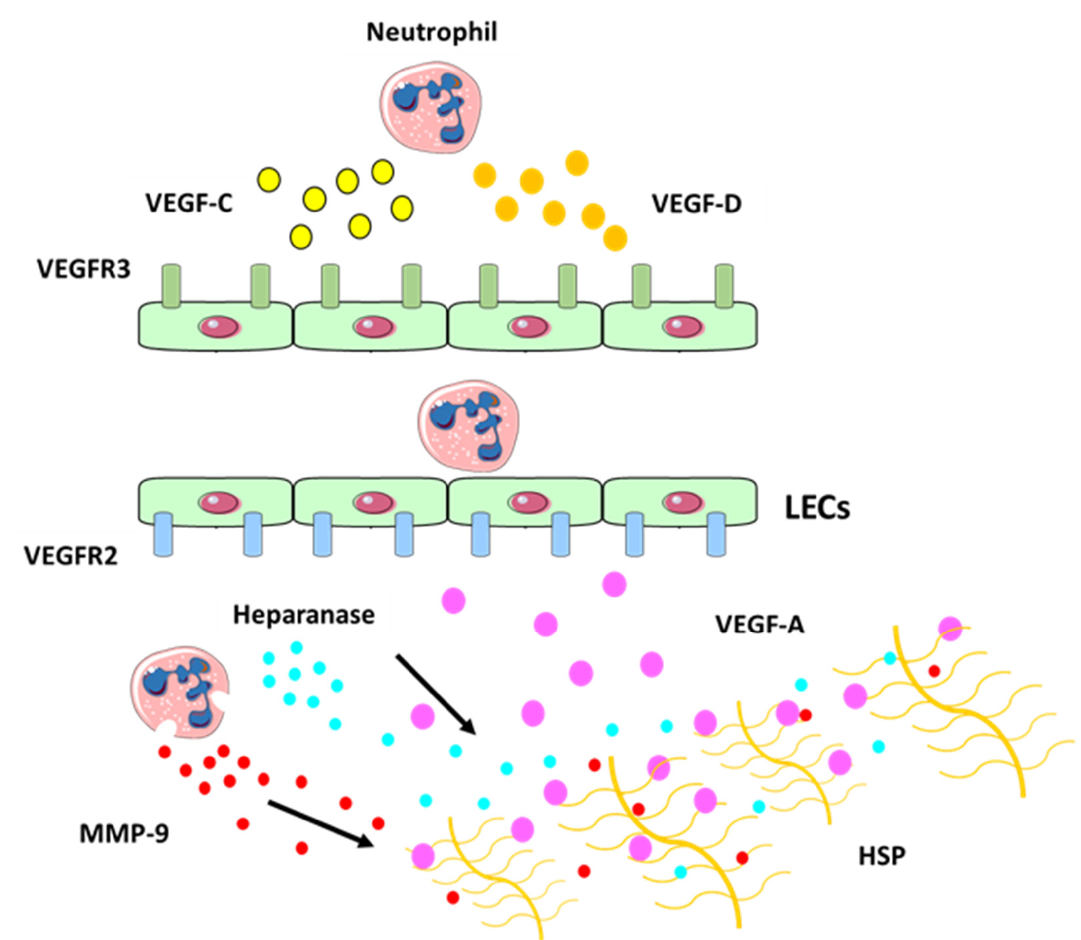
Figure 4. Neutrophil contribution to inflammatory lymphangiogenesis. Schematic illustrating neutrophil contributions to lymphangiogenesis at the site of inflammation. Neutrophils can secrete VEGF-C (in yellow) and VEGF-D (in orange) at the site of inflammation which bind to their receptor VEGFR-3 (in green) expressed on LECs. Neutrophils can also increase VEGF-A (in purple) availability by secreting MMP-9 and heparanase which cleaves heparan sulphate preoteoglycans (HSP) side chains and release the HSP-trapped VEGF-A. This binds to VEGFR-2 receptor (in blue), which promotes the expansion of the lymphatic vessel network [119] .